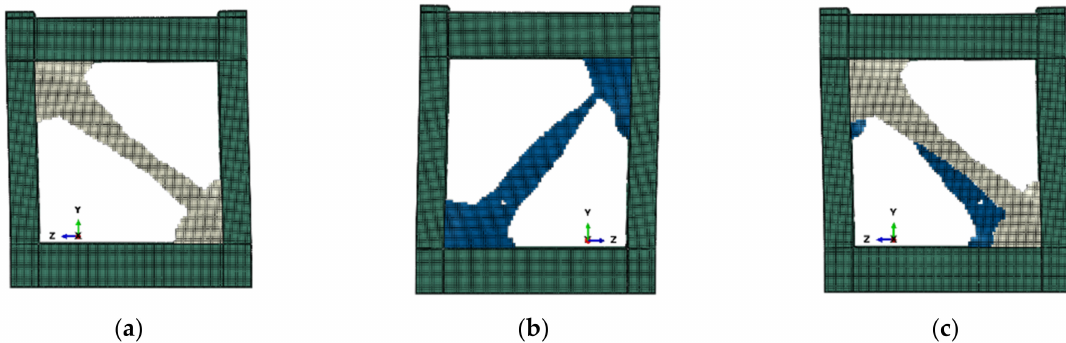
Figure 9. Nonlinear optimization results of SPSW with an aspect ratio of 1.0. ( a ) Front side ( b ) Reverse side. ( c ) Distribution of stiffening effect.